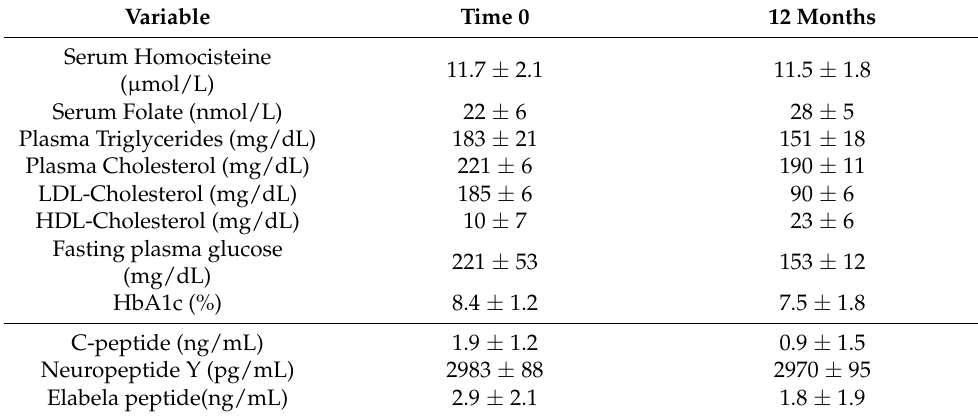
Table 4. Metabolic